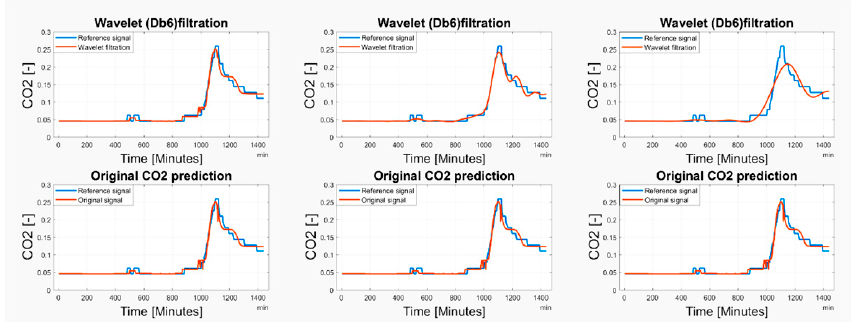
Figure 17. The comparison of the original predicted CO 2 signal and Wavelet filtration from 15 May 2018 for 2-level decomposition ( left ), 6-level decomposition ( middle ) and 7-level decomposition ( right ).